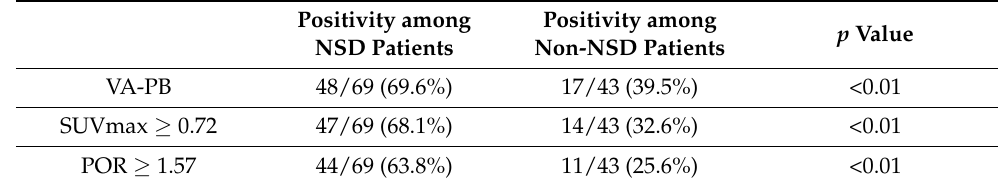
Table 3. Differentiation between NSD and non-NSD patients based on pineal body 18 F-DOPA uptake